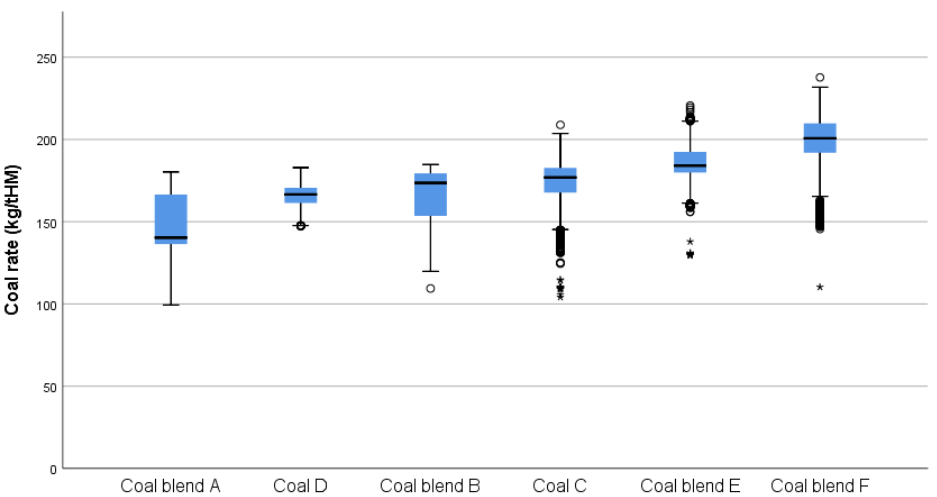
Figure 12. Box plots of the range of coal injection rates for each of the coals/coal blends used during blast furnace production (◦ represents outliers and * extreme outliers).